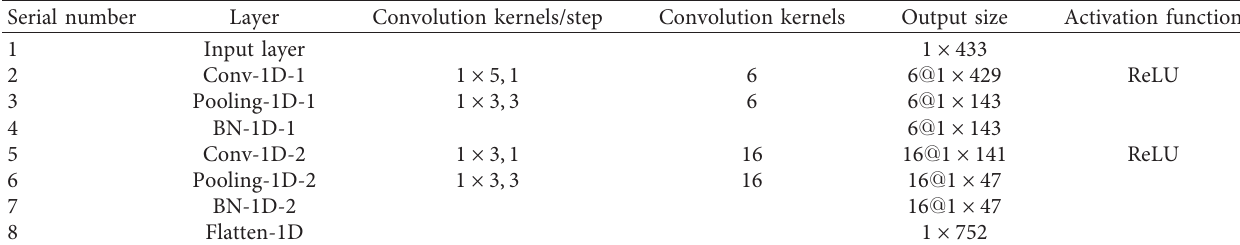
Table 1: 1D-CNN network parameter settings.